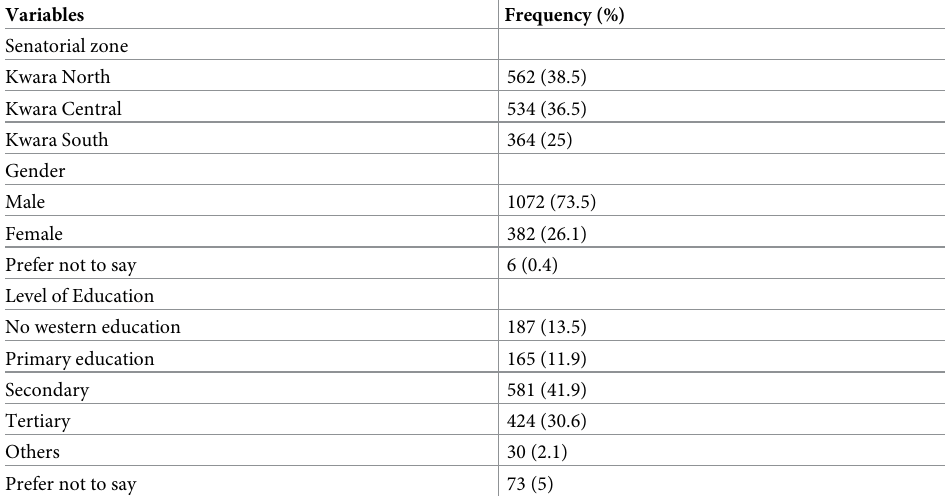
Table 2. Demographic data for respondents in the three senatorial zones of Kwara state (n =